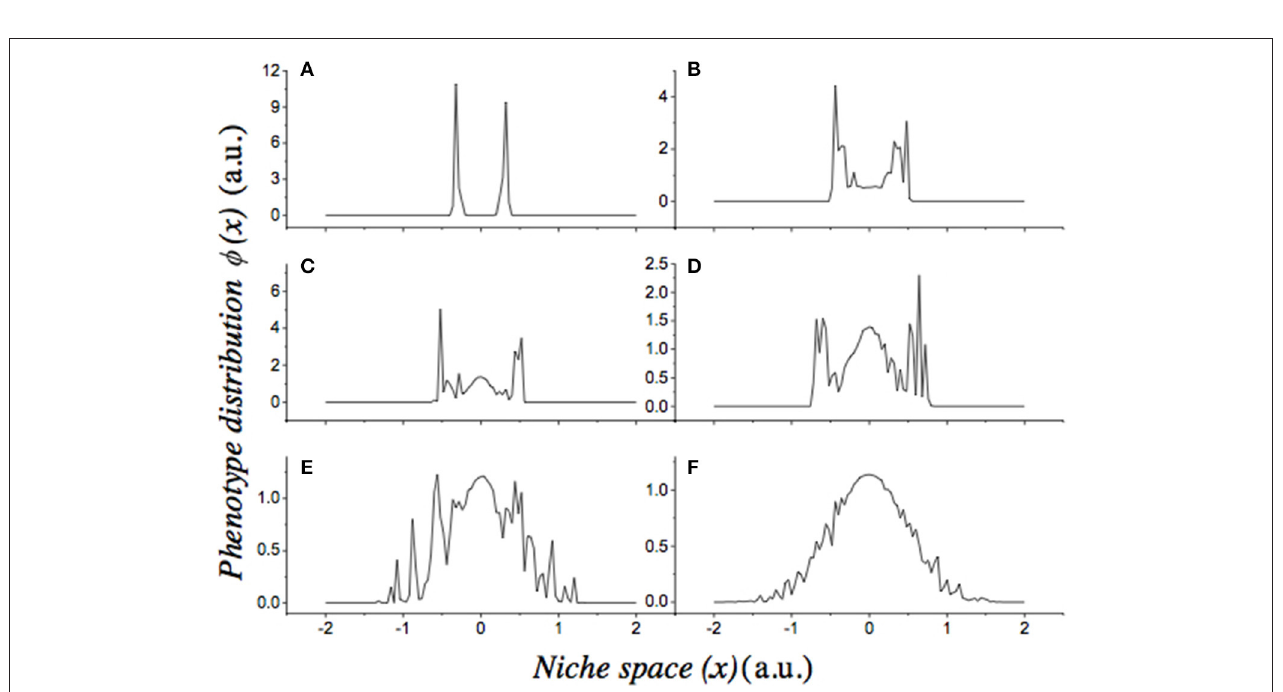
FIGURE 3 | Effect of noise on the stochastic dynamics of the Lotka-Volterra Competition model. Panels show the final phenotypic distributions ( φ ( x )) of independent stochastic simulations carried out under increasing levels of noise [ σ ξ ]. From panels (A–F) , the values of σ ξ are: 0.85, 0.65, 0.55, 0.45, 0.35, 0.15, respectively. In all cases, the initial condition is a bell–shaped distribution of phenotypes: φ ( x ,0) n k parameters: n α 2.0; and a regime of frequency-dependent selection. Parameters were: r = = steps. Both axes are in arbitrary units.